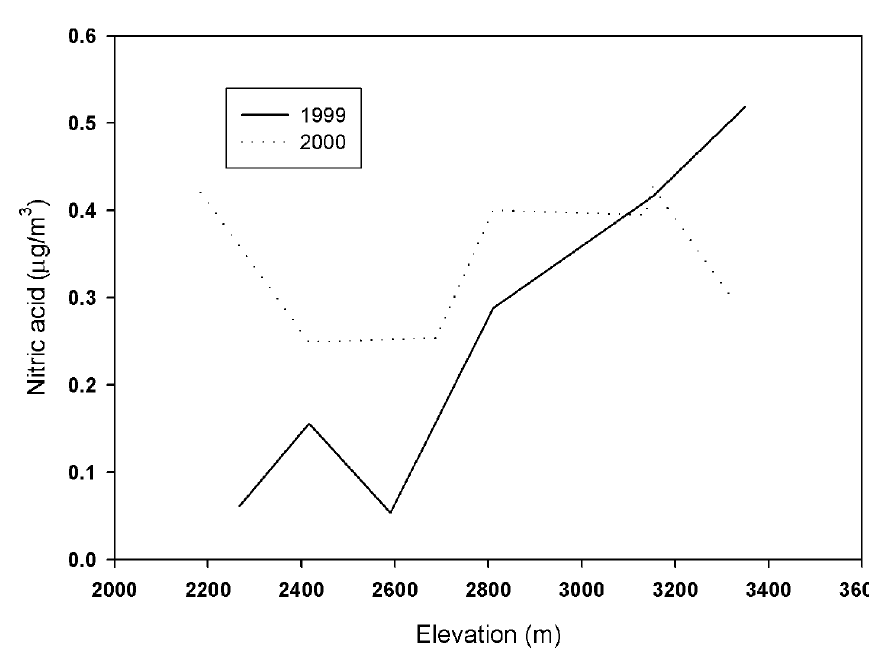
FIGURE 5 . Concentrations of HNO 3 determined with passive samplers on the Mammoth